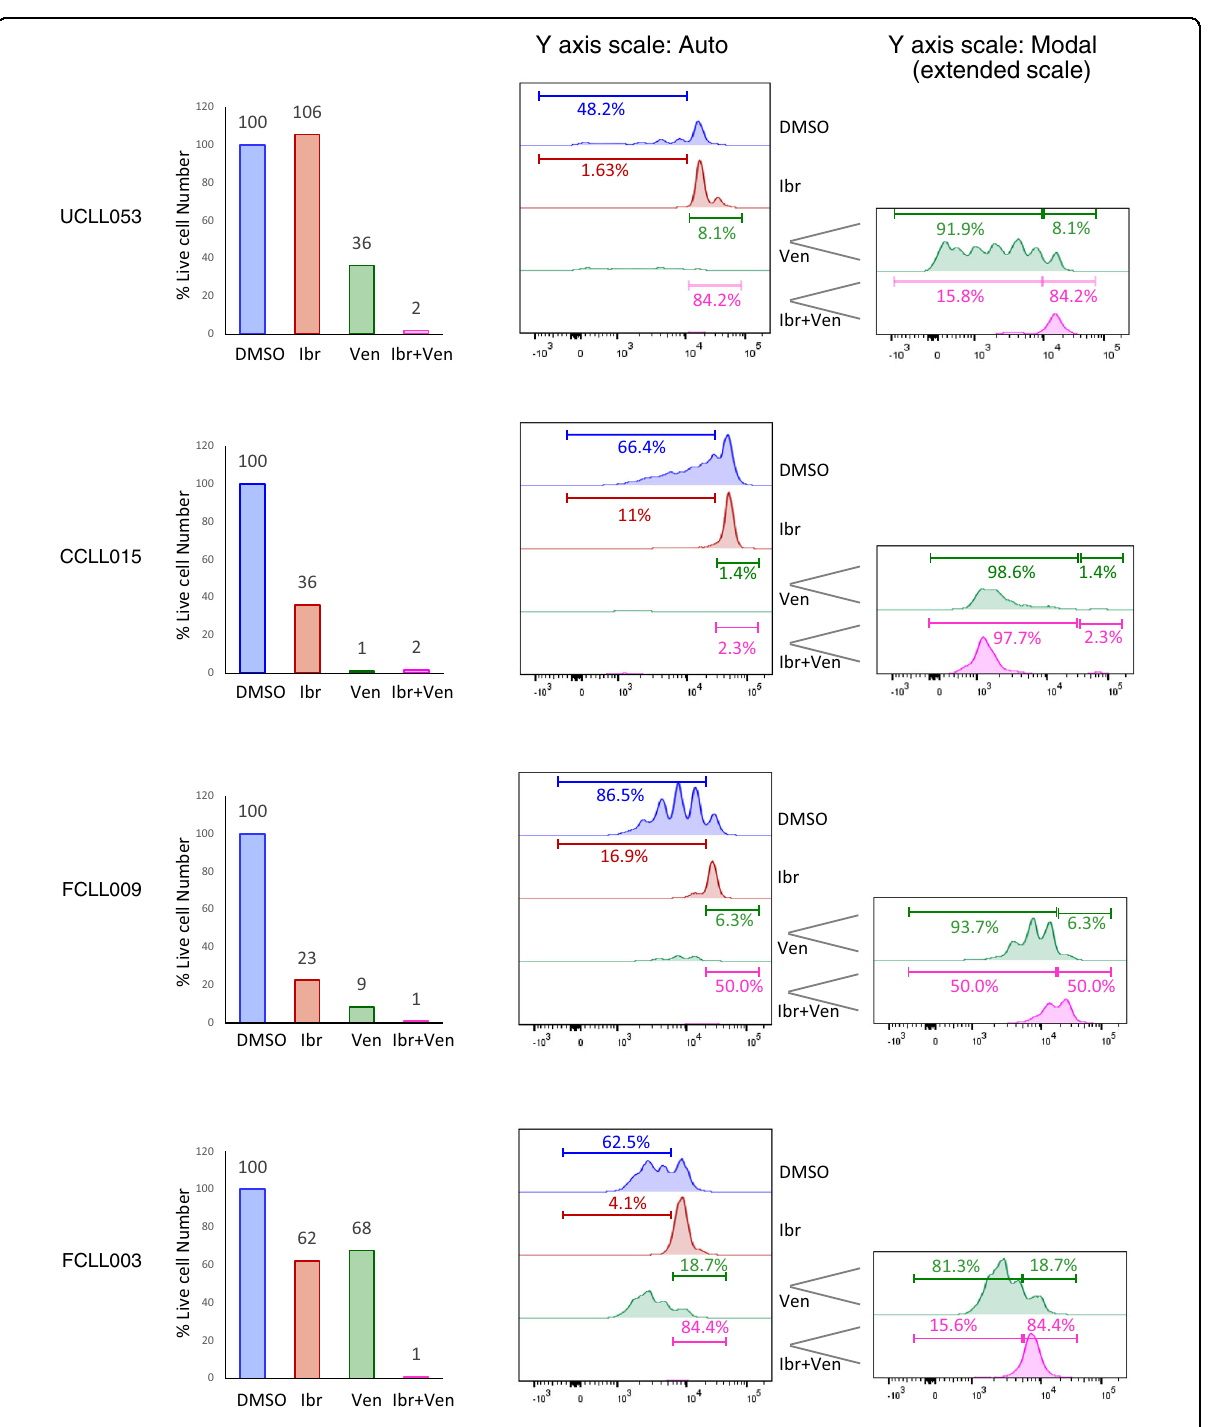
Fig. 4 Combination of ibrutinib and venetoclax effectively eliminates both resting and dividing CLL subpopulations in ibrutinib-sensitive cases. CFSE-labeled CLL cells were cultured with BMF + CpG/IL-15 in the presence of DMSO, 400 nM of ibr, 200 nM of venetoclax (ven) or both. All analyses shown were conducted at day 7 of the co-culture by fl ow cytometry. Live cell numbers (bar graphs) and CFSE pro fi les of four ibrutinib naïve/ sensitive cases are shown. Live cell numbers were normalize to the DMSO control (100%). Percentage of cells distributed in the dividing phases of the CFSE pro fi les is automatically calculated by the FlowJo software. Y axis scale-auto displays events on the same scale for all treatment conditions, and Y axis scale-Modal displays events on an extended scale to show low peaks under the conditions of ventoclax or combination